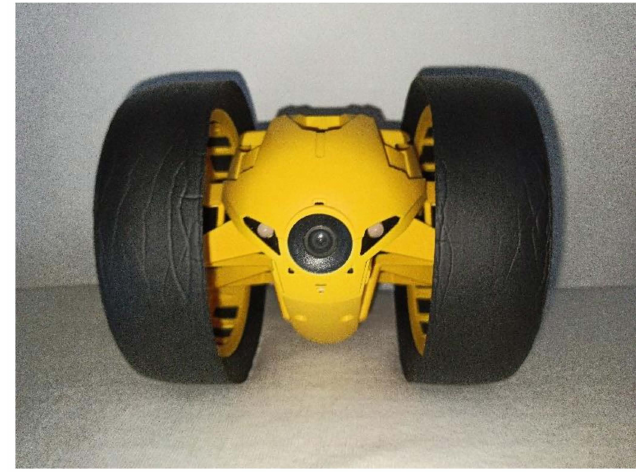
Figure 2. Tuk-tuk parrot